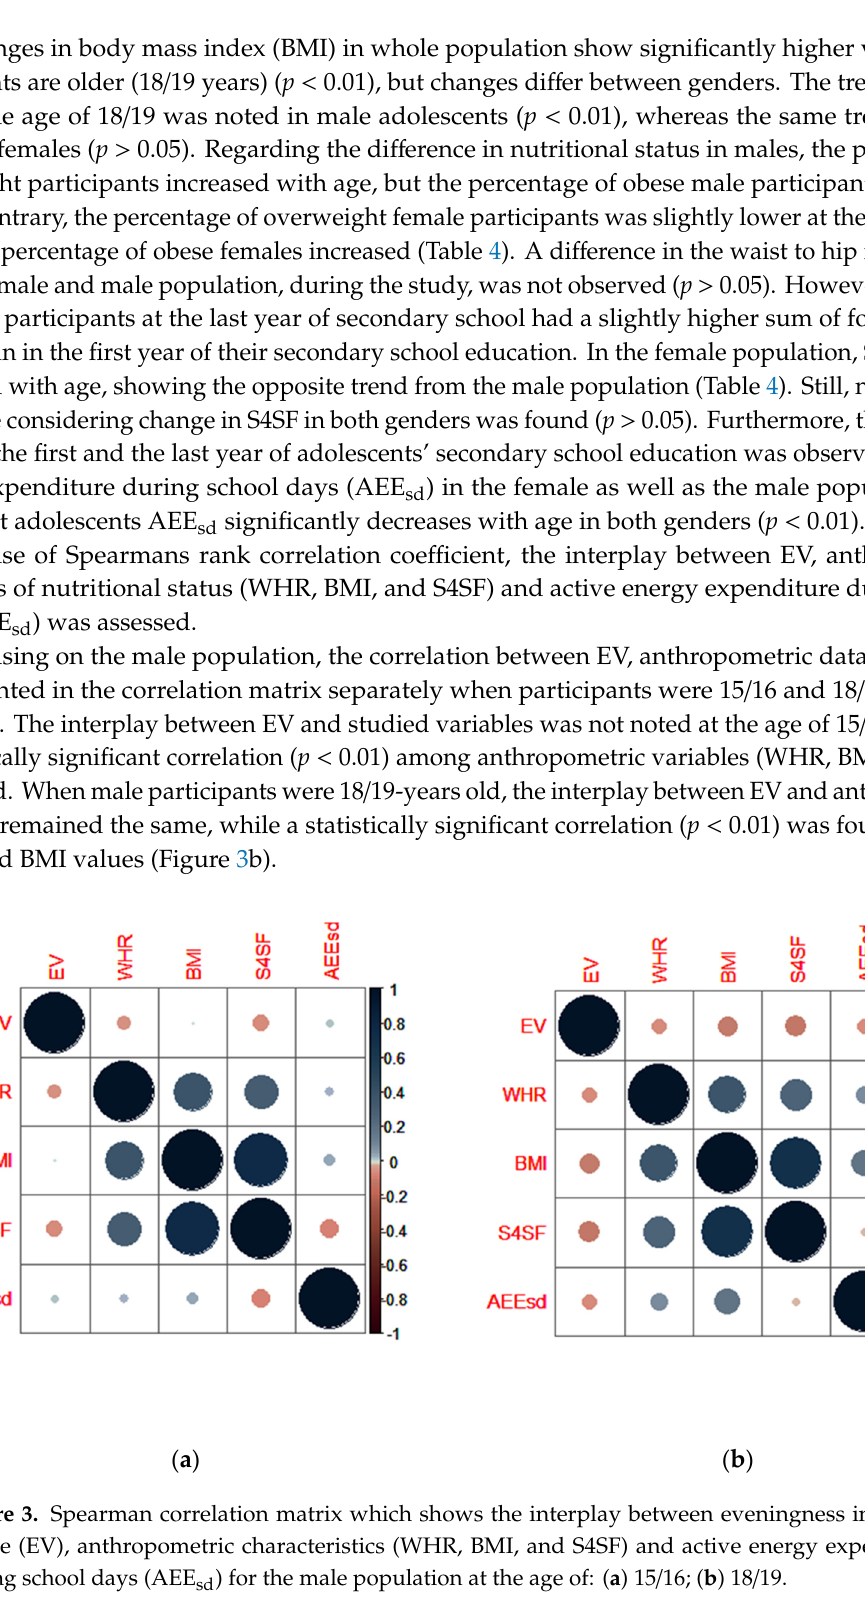
( b ) Figure 4. Spearman correlation matrix which shows the interplay between eveningness in energy intake (EV), anthropometric characteristics (WHR, BMI, and S4SF) and active energy expenditure during school days (AEE sd ) for the female population at the age of: ( a ) 15/16; ( b ) 18/19. The values of statistical significance of correlation ( p -values) as well as values of Spearmans rank correlation coefficients between variables are available in the Supplementary Data (Tables S1–S8). These tables showed an interplay between eveningness (EV), energy expenditure during school days (AEE sd ), and anthropometric indicators of nutritional status in all age and gender groups (Tables S5–S8). The previously observed significant correlation between WHR and EV among female adolescents at the age of 15/16 prompted us to examine the potential changes in the examined